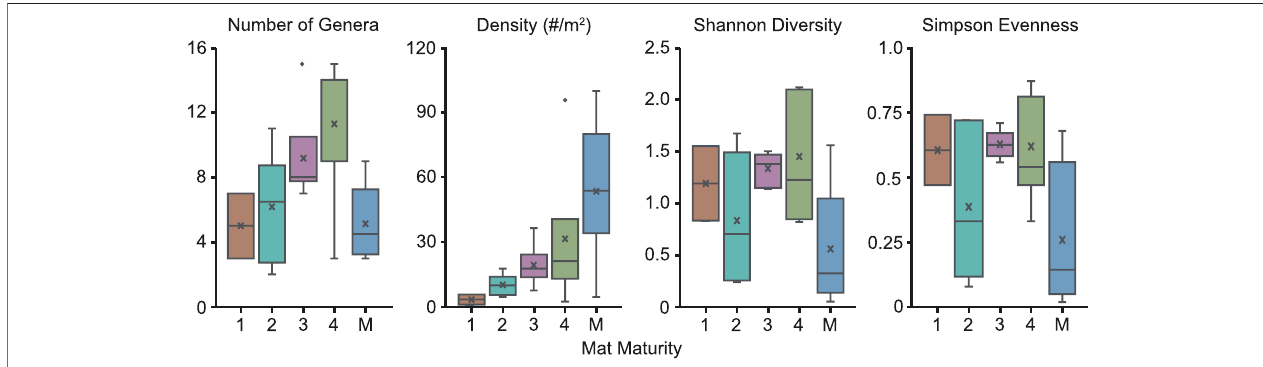
FIGURE 9 | Box and whisker plots demonstrating how various paleoecological metrics correspond to mat maturity. M = multicellular TOS. (A) Number of genera. (B) Density (number of organisms/meter 2 ). (C) Shannon Diversity. (D) Simpson Evenness. All beds with multicellular TOS have a MMI of 4. However, they are unique in thattheydonotnecessarilyrepresentasimilaramounttimebetweendepositionaleventsasMMI4bedsdominatedbynon-multicellularorganisms.Thus,thesebedsare not included with the other MMI 4 beds in this fi gure but are illustrated separately.